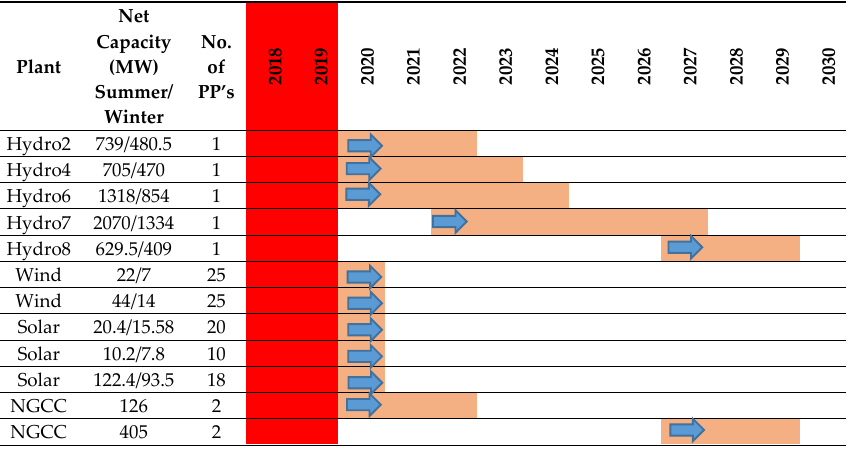
Table A8. Details of the Plants Installation under Capacity Expansion: Normal GDP Fuel Balancing (3–30% Mitigation).